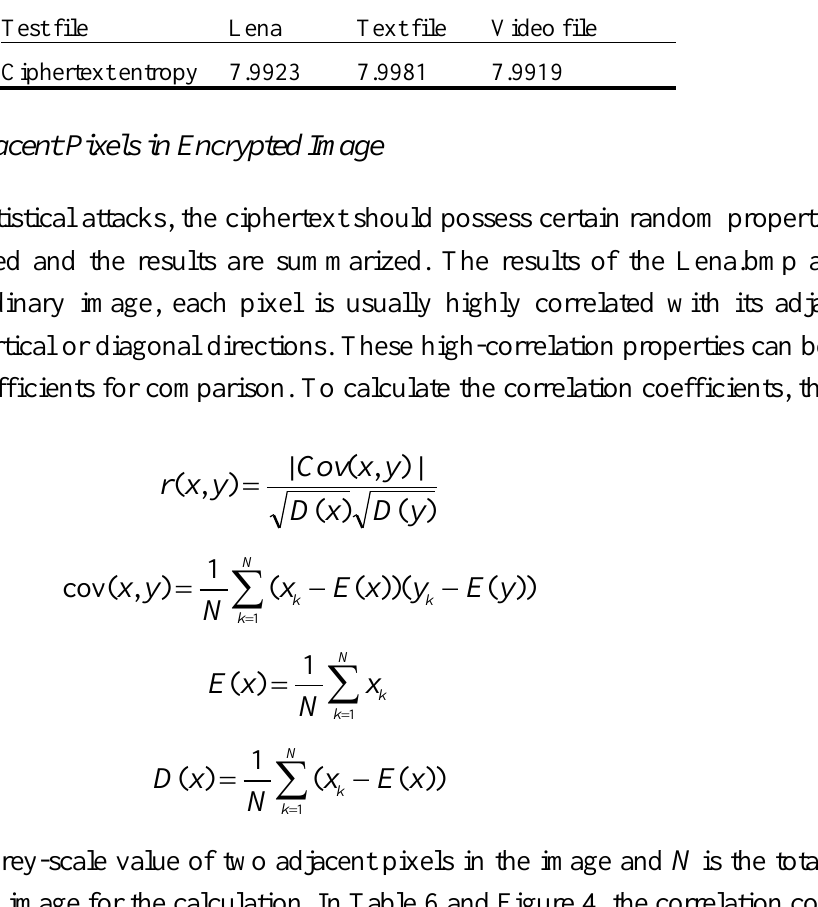
Table 5. Entropy test result.